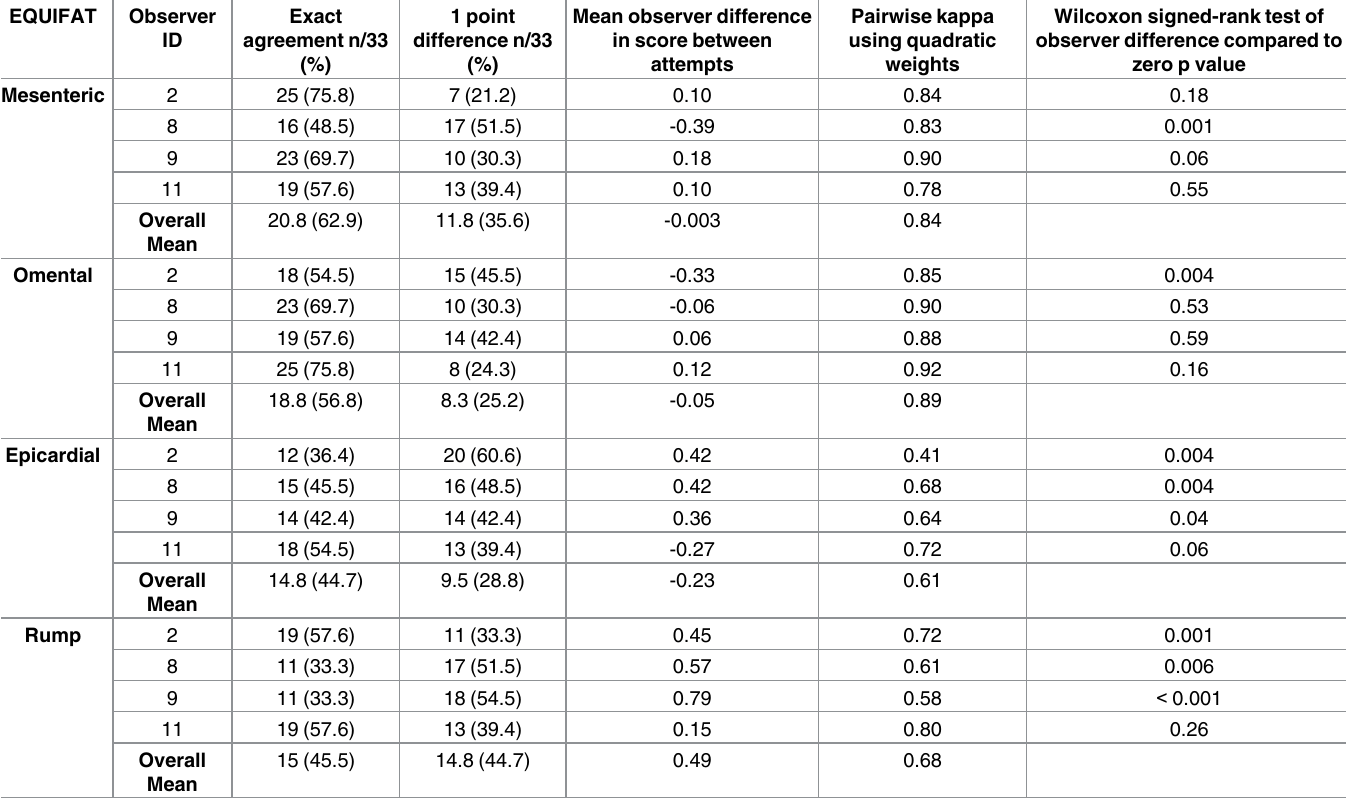
Table 3. Intra-observer repeatability of the EQUIFAT scores for the four observers using half scores and assessing 33 images each of 4 adipose depots. A minimum of 14 days lapsed betweenattempts. Agreement data are presentedfor exact and 1 point differences betweenattempts. Kappa tests and p values for Wilcoxon sign-ranktest are